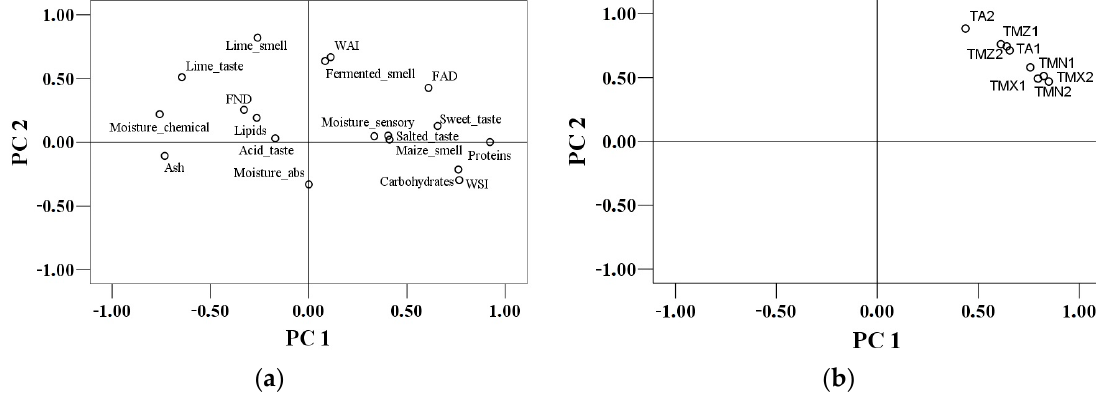
Figure 2. Principal component analysis: distribution of chemical (moisture, ash, proteins, lipids, neutral detergent fiber (FND), acid detergent fiber (FAD), carbohydrates, water absorption index (WAI), water soluble solids index (WSI)) and sensory (moisture absorption, acid taste, lime taste, lime smell, fermented smell, moisture sensory, salted taste, sweet taste, maize smell) analyzed parameters ( a ). Distribution of tortillas samples (TMX—tortillas from maize grains and industrialized corn flour; TMZ—tortillas from locally grinded and nixtamalized maize grains only; TMN—tortillas from industrialized maize flour; and TA—artisanal hand-made tortillas) in the function of the analyzed parameters ( b ).